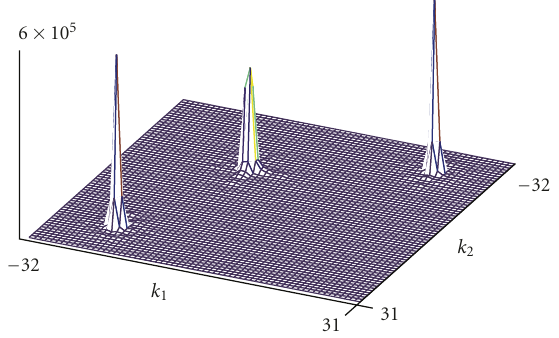
Figure 7: S/SF representation of the analyzed signal (5) in ( n 1 T , n 2 T ) = ( − 0 . 25, − 0 . 25), obtained by using the proposed hardware design with L m = 5, implemented in FPGA